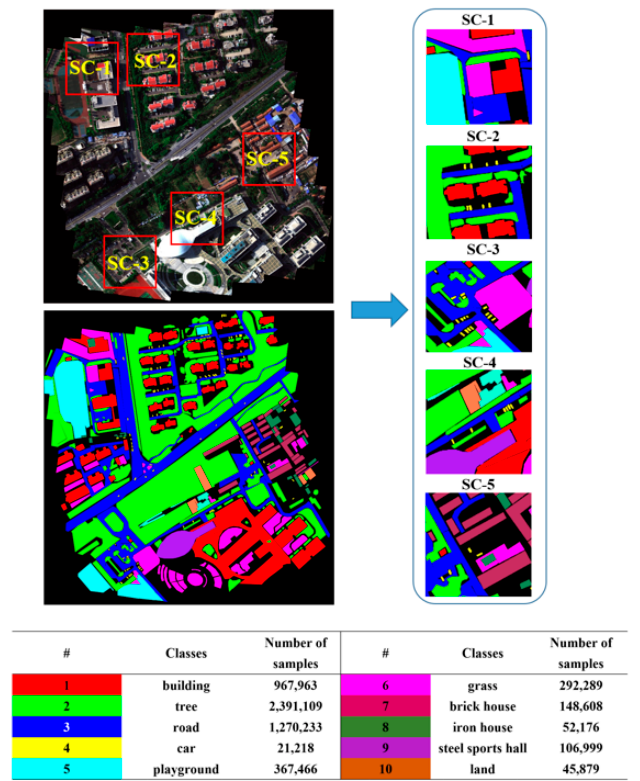
Figure 2. Examples of the self-collected HSI datasets, where SC-1 to SC-5 are small patches of 500 × 500 pixels each, cropped from a large hypercube of 3091 × 3129